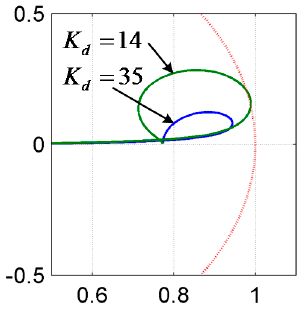
Figure 15. The root trajectories of H ( z ) with different K d .